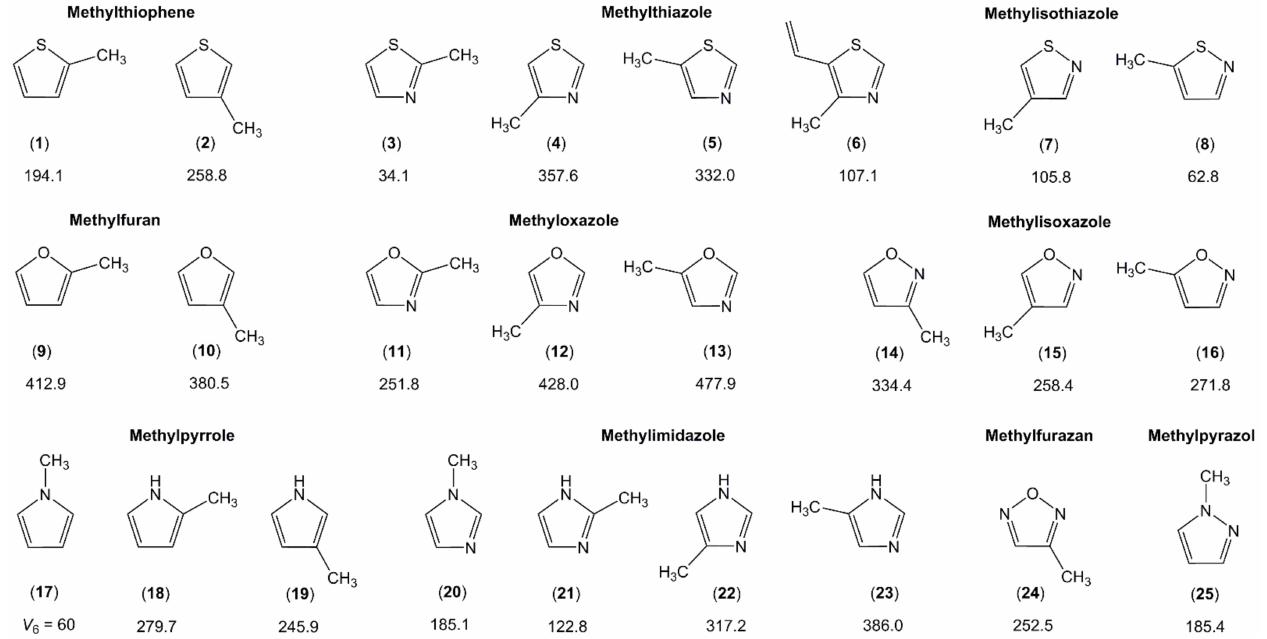
Figure 3. Barriers to methyl internal rotation in monomethyl-substituted planar five-membered rings (in cm − 1 ). ( 1 ) 2-methylthiophene [96], ( 2 ) 3-methylthiophene [97], ( 3 ) 2-methylthiazole